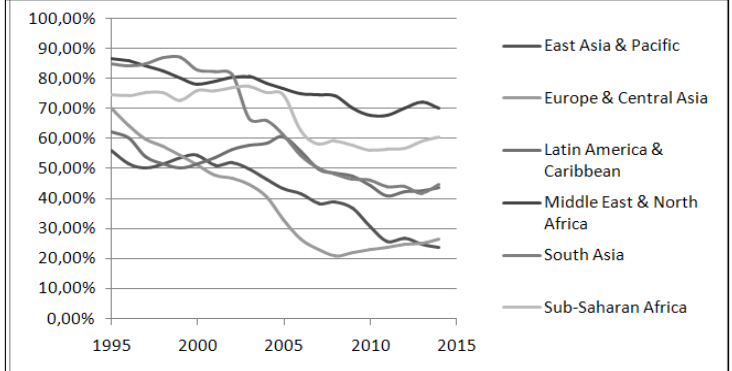
Fig. 2. Trends in PPG external debt as a percentage of total gross external debt